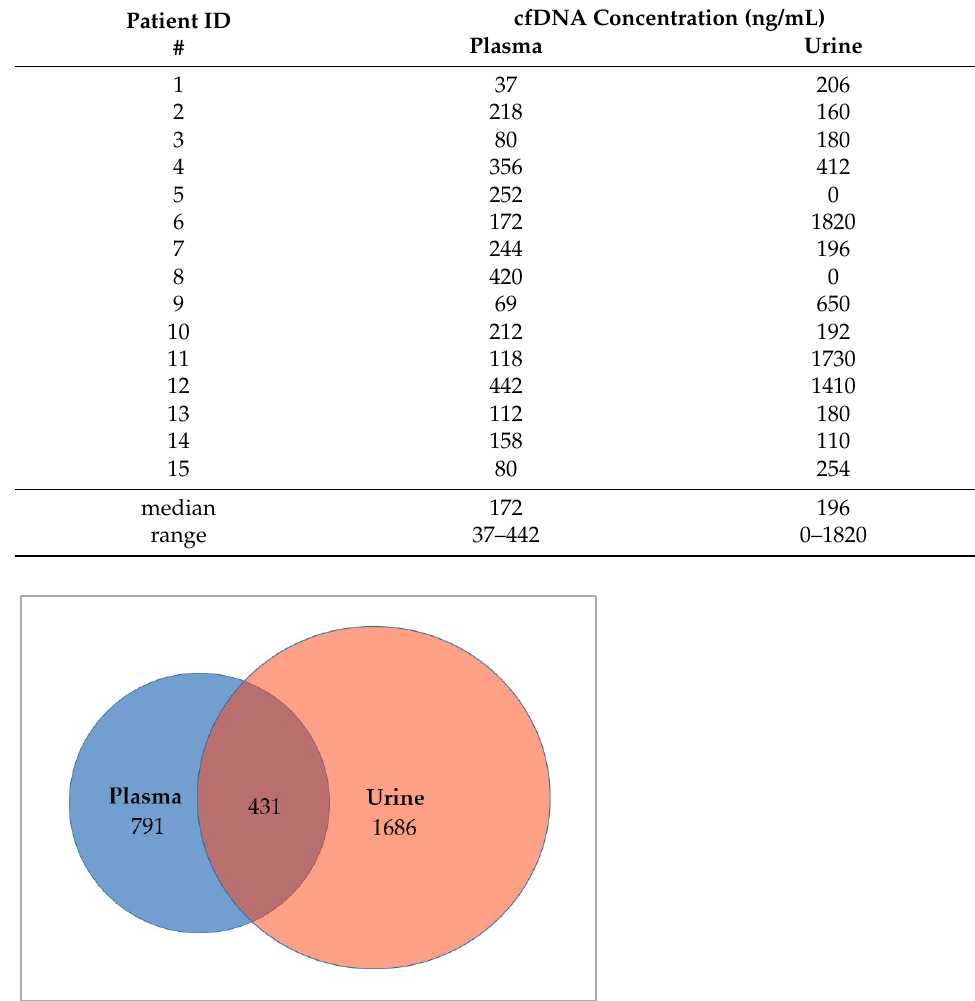
Figure 2. Boxplot showing the number of variants found in plasma and urinary ctDNA. Per plasma sample, a median number of 66 variants were found in ctDNA, ranging from 46 to 261 variants. In contrast, a median number of 110 variants were obtained per urinary ctDNA sample, ranging from 36 to 320 variants. Medians and interquartile ranges are displayed. The mean value is marked with an x. 3.3. Abundance of Detected Variants in Plasma and Urinary ctDNA At the time being, it is common to use the variant allele frequency (VAF) as a quan- titative measure of a tumor-specific variant. It is expressed as the ratio between the num- ber of mutated and wild-type DNA copies [35]. Hence, VAF is the percentage of sequence reads observed, matching a specific DNA variant divided by the overall coverage at that locus [36] . If reference material is not available, VAF might be used to distinguish somatic and germline mutations. The latter ones are present with either 50% if heterozygous or 100% if homozygous [37]. However, somatic variants which are acquired usually present lower VAF, because they do not occur in all cells. For many tumor sequencing applica- tions, 5% VAF mutation sensitivity is sufficient [38]. Here, we separated all variants into five groups: VAF 3 ≤ 5 %, 5 ≤ 1 0%, 10 ≤ 2 0%, 20 ≤ 5 0% and 5 0–100 %. The distribution of allele frequencies separated for plasma and urine is shown in Figure 3. Of all variants isolated from the ctDNA of both body fluids, 1226 (37%) had a very low abundance with VAF of 3 ≤ 5 % , and 1061 (32%) variants showed a low abundance with a VAF in the range of 5 ≤ 1 0%. Further, 633 (19%) variants appeared with an intermediate abundance which